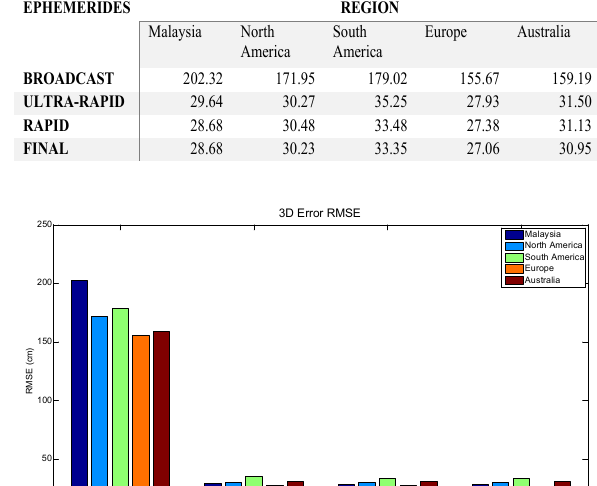
Table 3. 3D Error RMSE of PPP solution